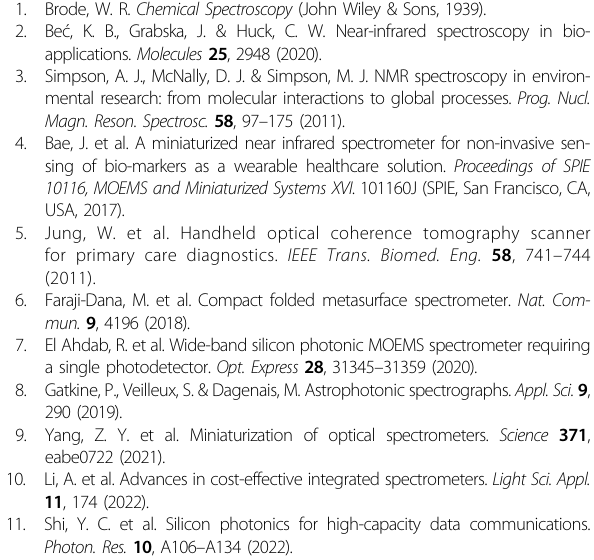
obtained based on the fi nite element method (FEM). The transmission responses and light propagation pro fi les of SDCs and BDCs are calculated with the fi nite-difference time-domain (FDTD) method. The calculation of the transmission matrix is carried out through the co-simulation in the ANSYS Lumerical INTERCONNECT module. Measurement method The transmission responses of the spectrometer were measured by using a narrow-linewidth TL (Keysight 8164B) and a synchronized PM (Agilent 81532A). A pro- grammable power source (Keithley 2400) was employed to scan the heating power. The fabricated chip was mounted on a commercial thermo-electric cooler (TEC) to stabilize the ambient temperature. The spectrum- reconstruction setup is detailed in Supplementary infor- mation, Section S14.